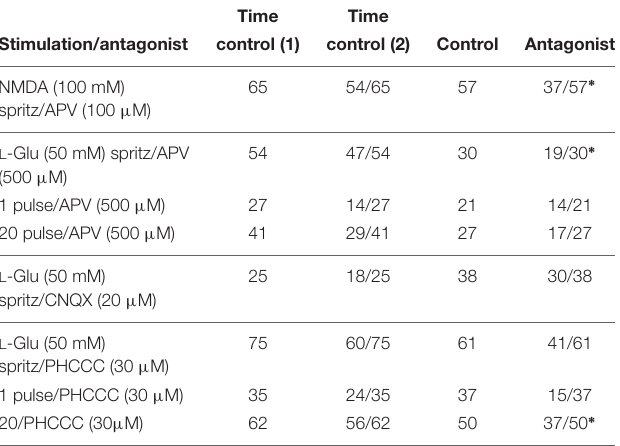
TABLE 2 | Number of responding neurons during time controls and in the presence antagonists. Time Time Stimulation/antagonist control (1) control (2) Control Antagonist